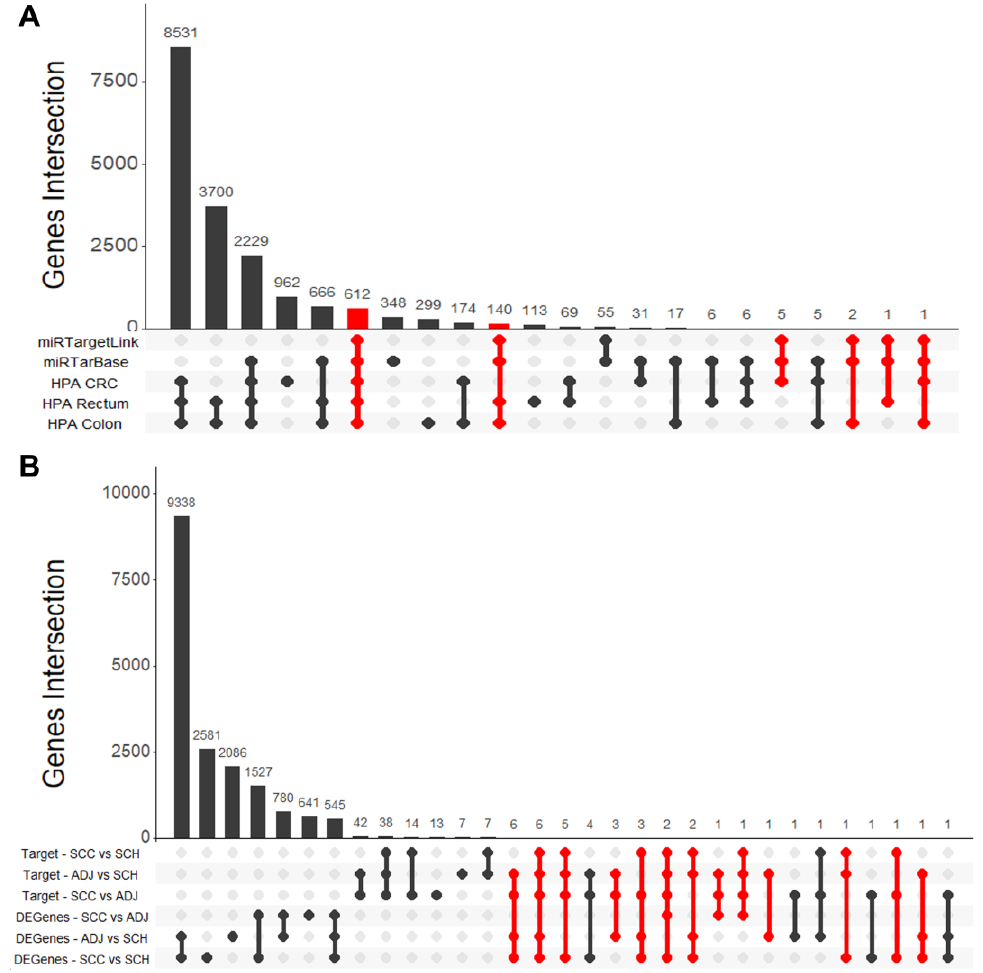
Figure 6. Upset plot for the select target genes to perform ( A ) gene enrichment and ( B ) an integrative analysis. Firstly ( A ), we selected target genes expressed in the healthy colon (HPA Rectum and HPA Colon) and CRC (HPA CRC), related to Human Protein Atlas databases. These genes were used to perform gene enrichment analysis. Then ( B ), we selected a gene subset to perform integrative analysis. For this, we considered only the genes that were involved with 23 cancer-related pathways subsets and were di ff erentially expressed using TCGA and GTEx dataset. Highlighted in red are the genes selected to perform this analysis. The UpSetR package v.1.4.0 was used to create the